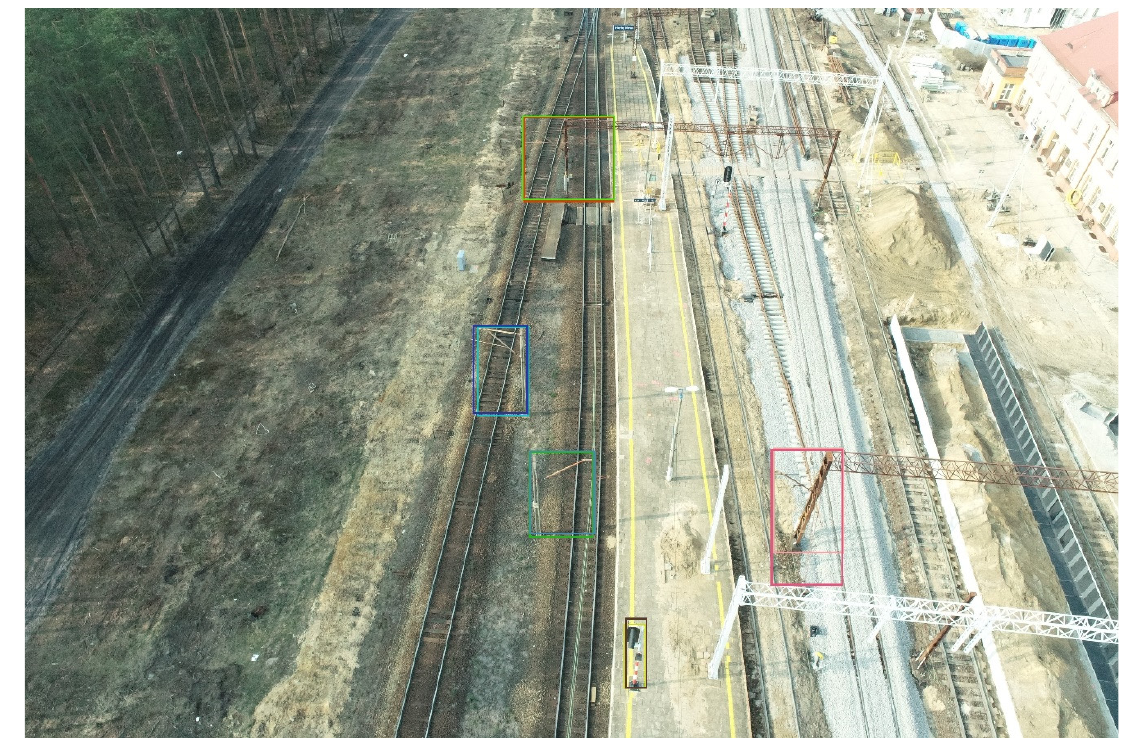
Figure 18. An example of comparing bounding boxes for traction poles obtained using automatic generation from ground-truth for the entire image. From the top, IoU values: 0.9748, 0.9116, 0.9675, 0.7411, 0.8496.